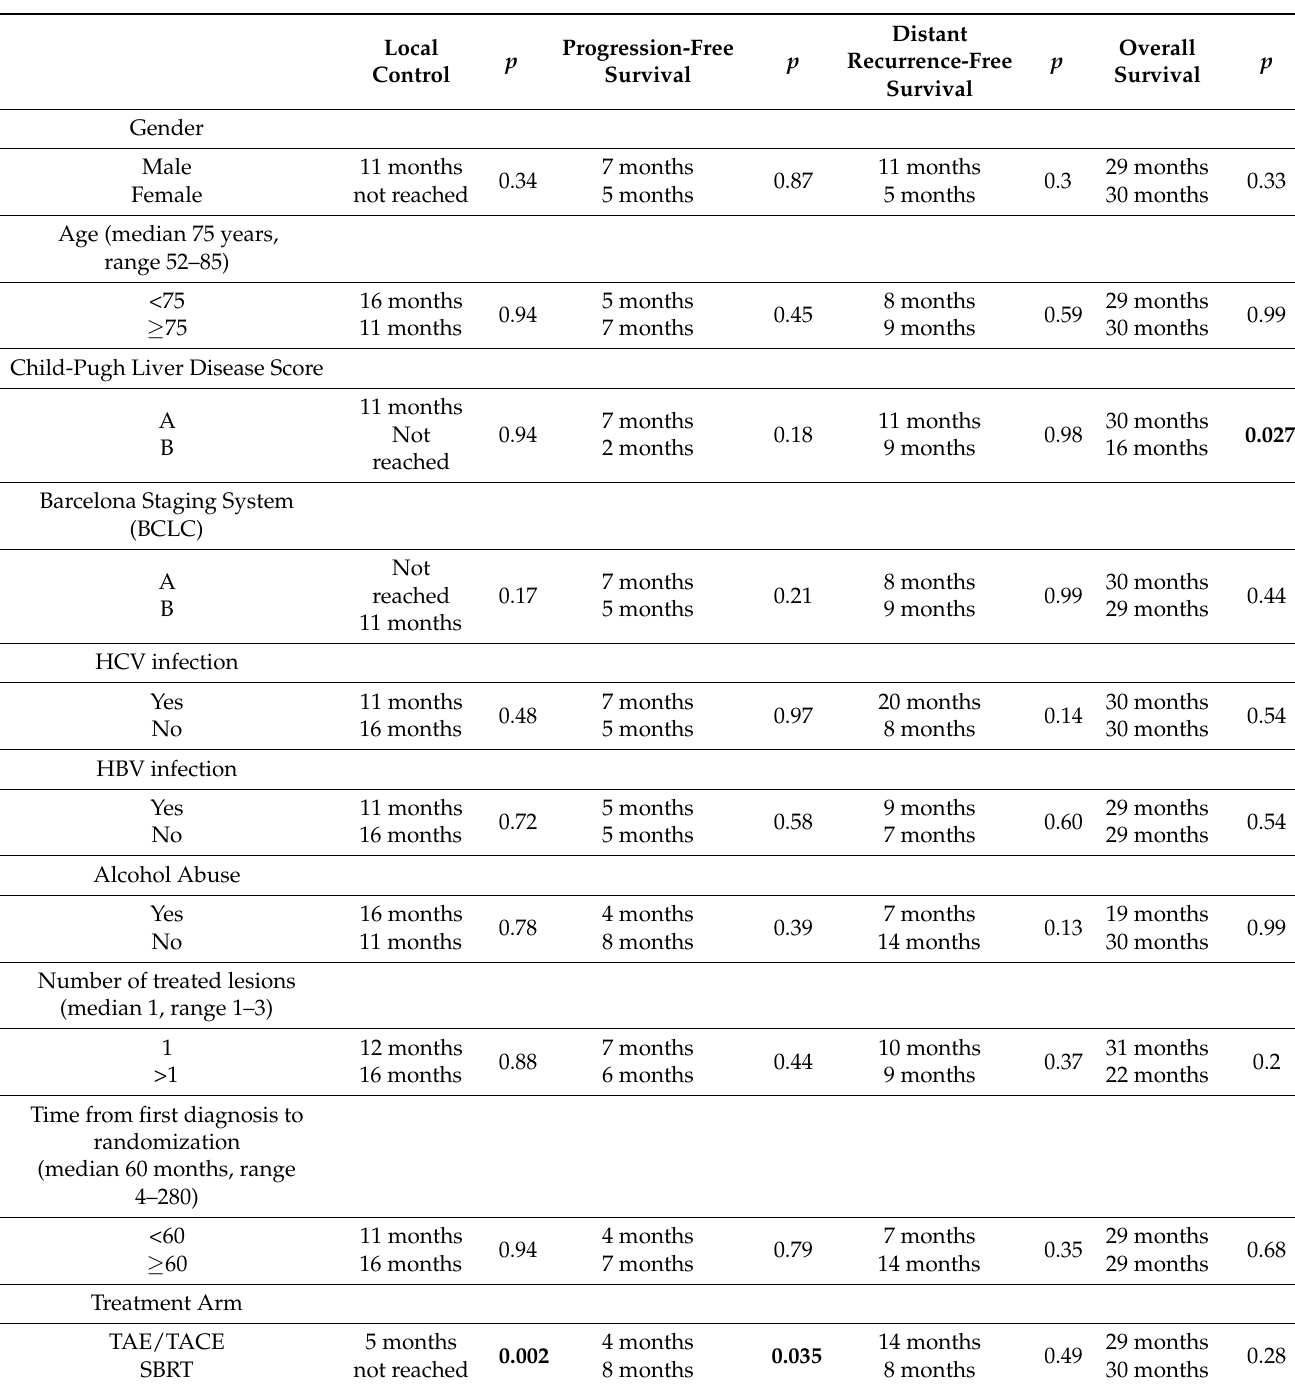
Table 2. Statistical analysis assessing the impact of clinical- and treatment-related variables on out- come. SBRT: Stereotactic Body Radiotherapy. TAE/TACE: Transarterial Embolization/Transarterial